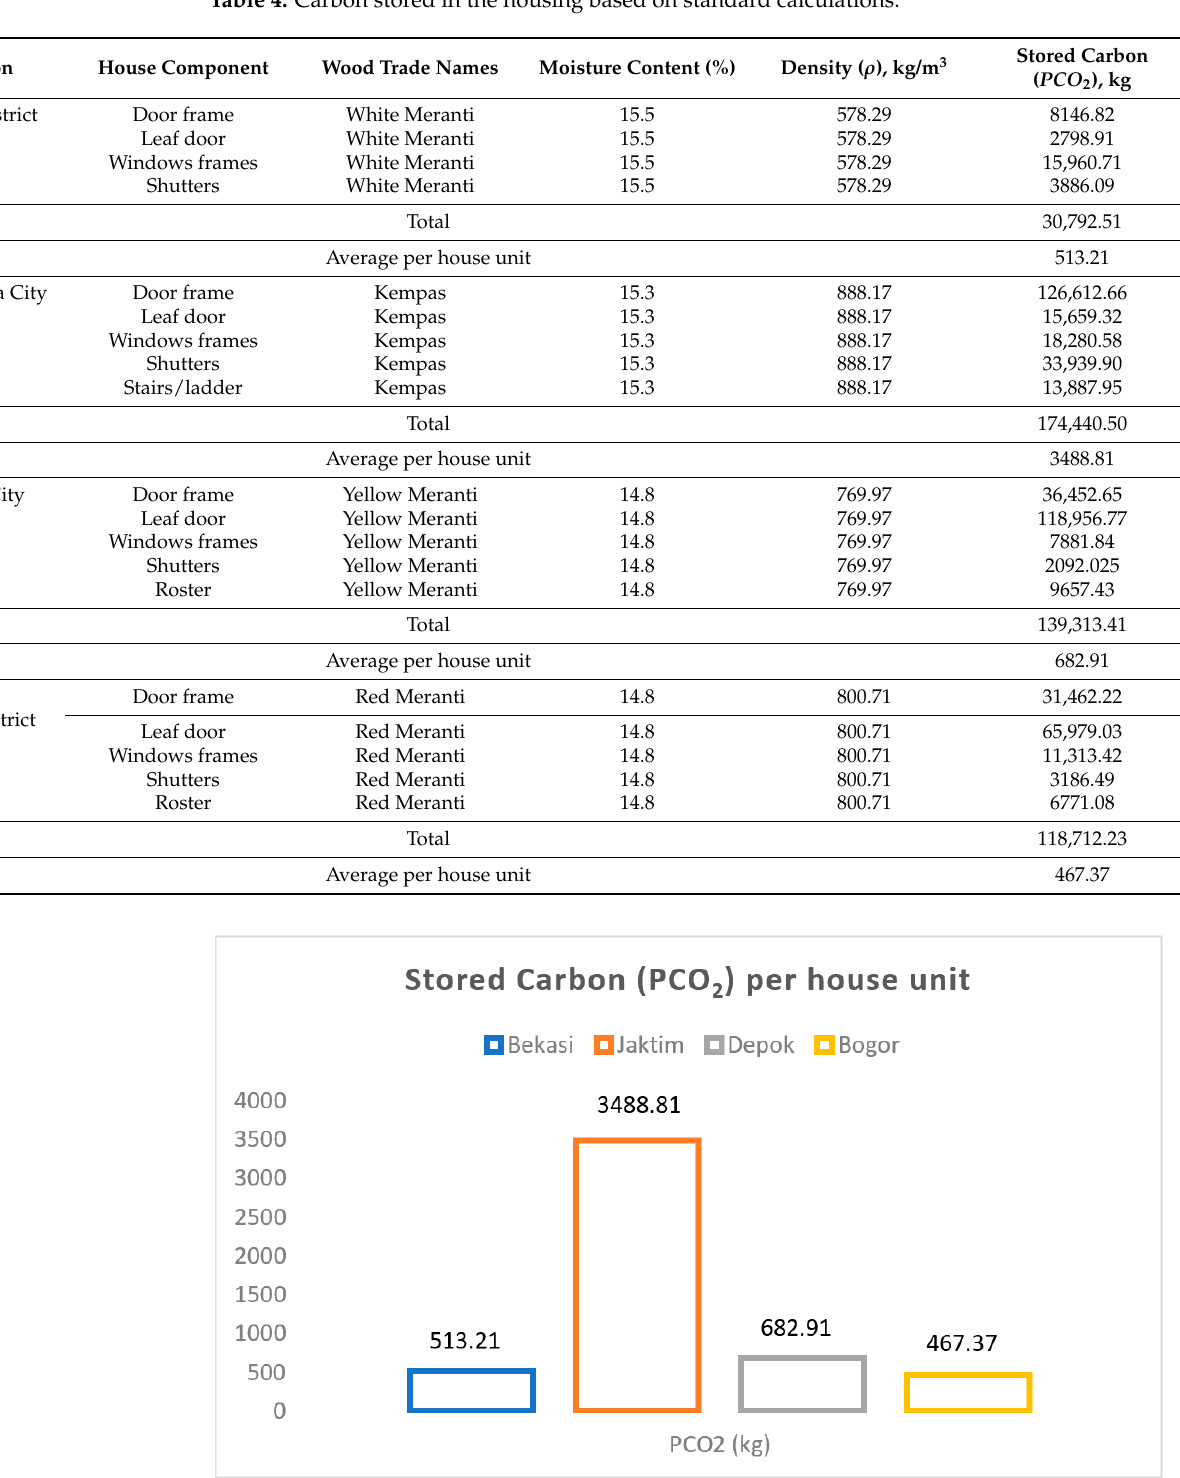
Table 4. Carbon stored in the housing based on standard calculations.